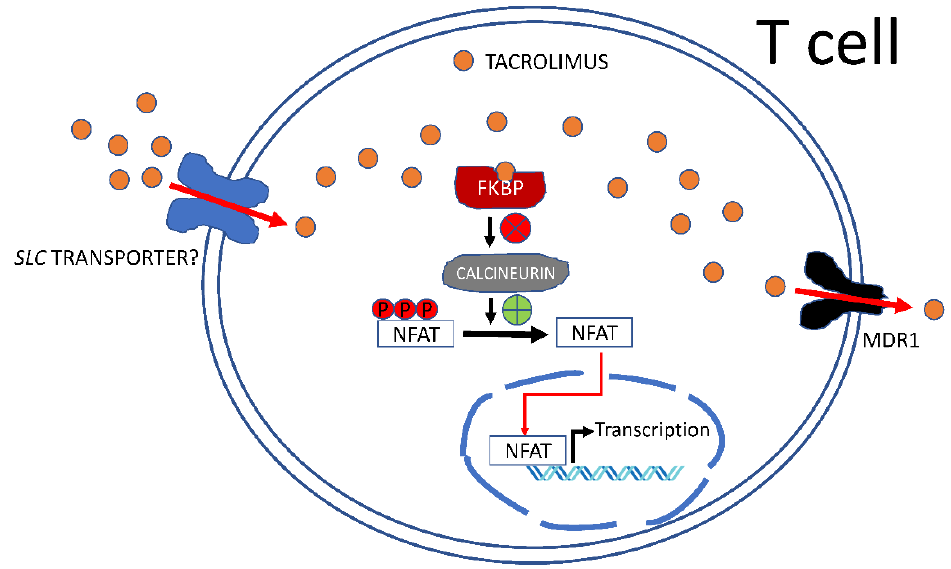
Figure 1. Tacrolimus handling by T cells. Tacrolimus accumulation in T cells determines the extent of calcineurin inhibition by tacrolimus-bound FK506 binding proteins (FKBP) and the subsequent inhibition of nuclear factor of activated T cell (NFAT) target genes, thereby contributing to immunosuppression. Tacrolimus intracellular concentrations are highly dependent upon the expression and functional activity of the ABCB1 gene product, multidrug-resistance 1 (MDR1)/P-glycoprotein. Tacrolimus influx might be mediated by a still-unknown plasma membrane transporter presumably belonging to the SLC gene superfamily. The contribution of inward tacrolimus transporters to drug accumulation in T cells is not known and opens the possibility of additional gene(s) modulating its calcineurin inhibitory activity.